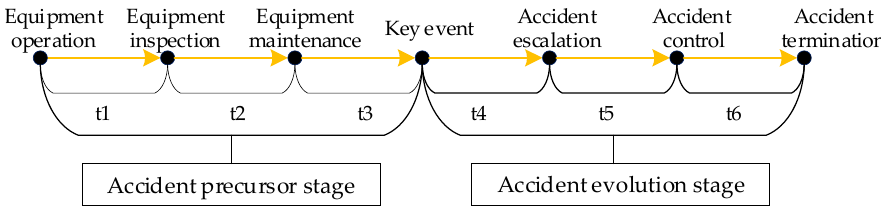
Figure 3. Window of opportunity during accident evolution stage.